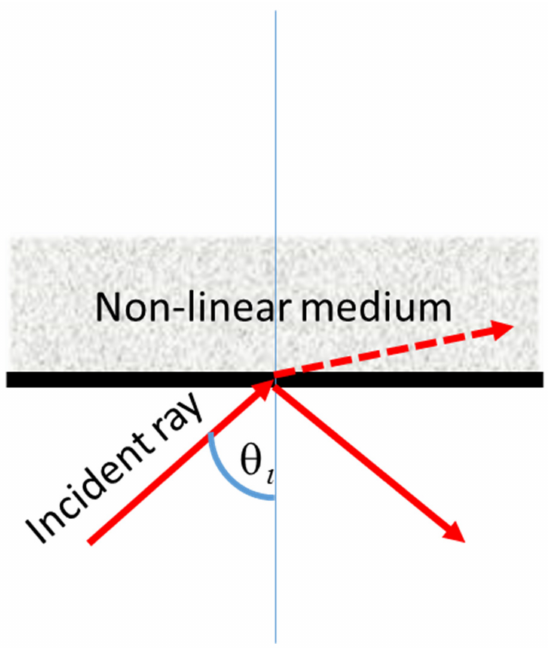
Figure 5. A non-linear optical